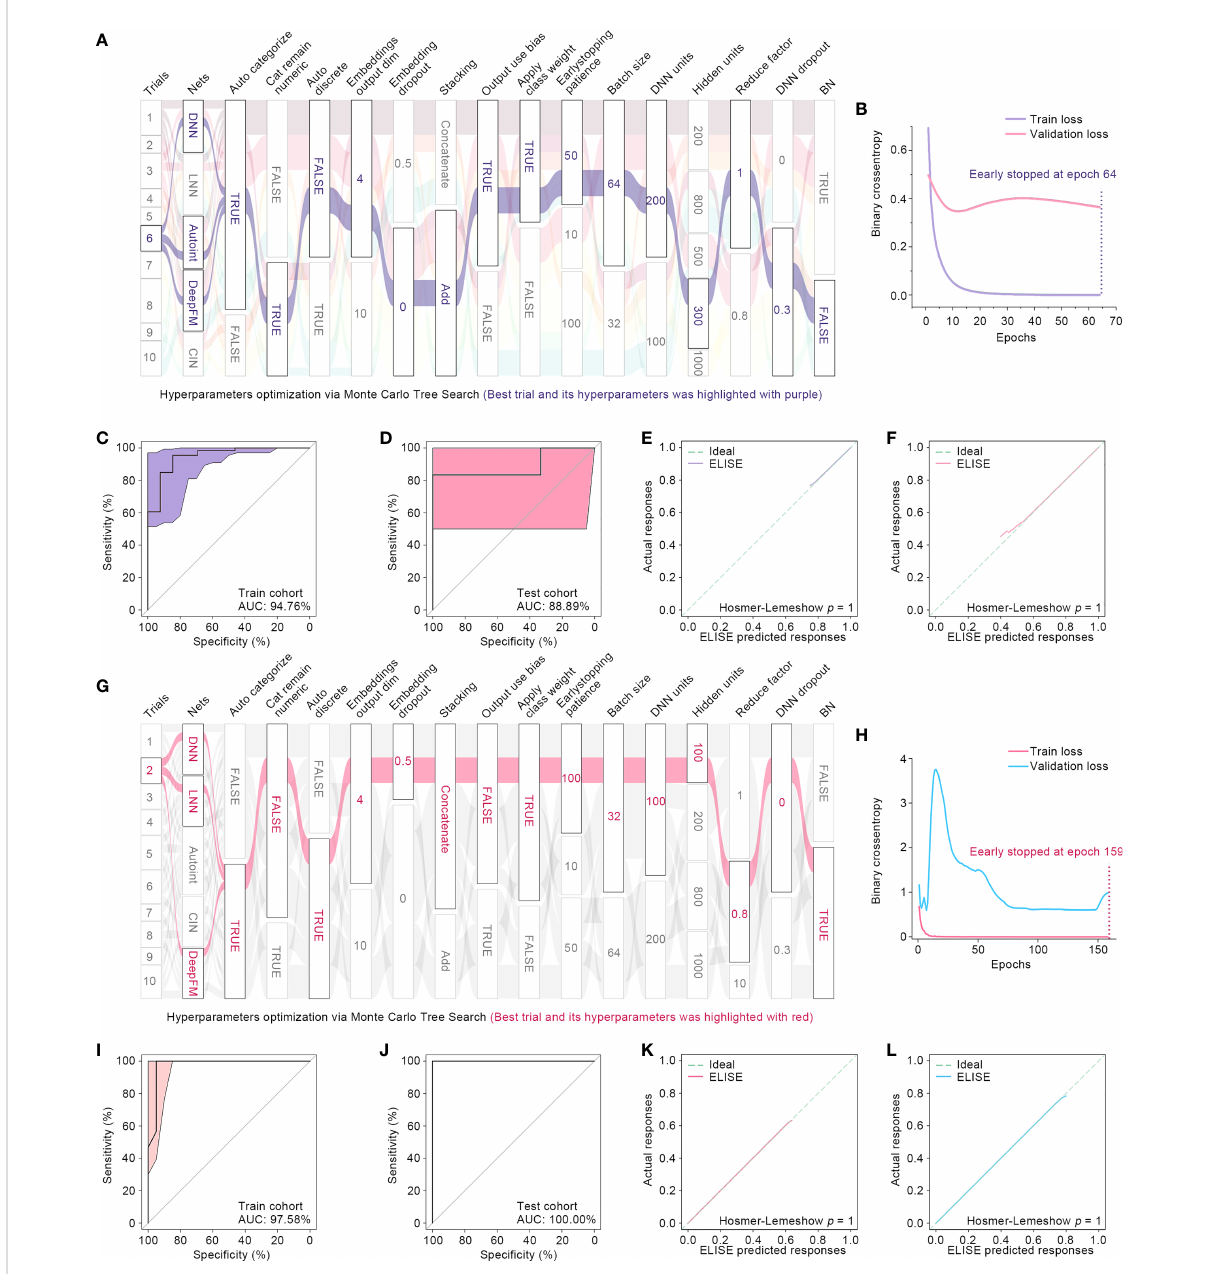
FIGURE 6 ELISE applied in UCs and melanoma. (A) Hyperparameter optimization in UCs. (B) Loss function curves in UCs. (C, D) AUCs of ELISE applied in UCs in the train and test cohort. (E, F) are the calibration plots of ELISE in the train and test cohort, respectively. (G) Hyperparameter optimization in MELANOMAs. (H) Loss function curves in MELANOMAs. (I, J) AMELANOMAs of ELISE applied in MELANOMAs in the train and test cohort. (K, L) are the calibration plots of ELISE in the train and test cohort,